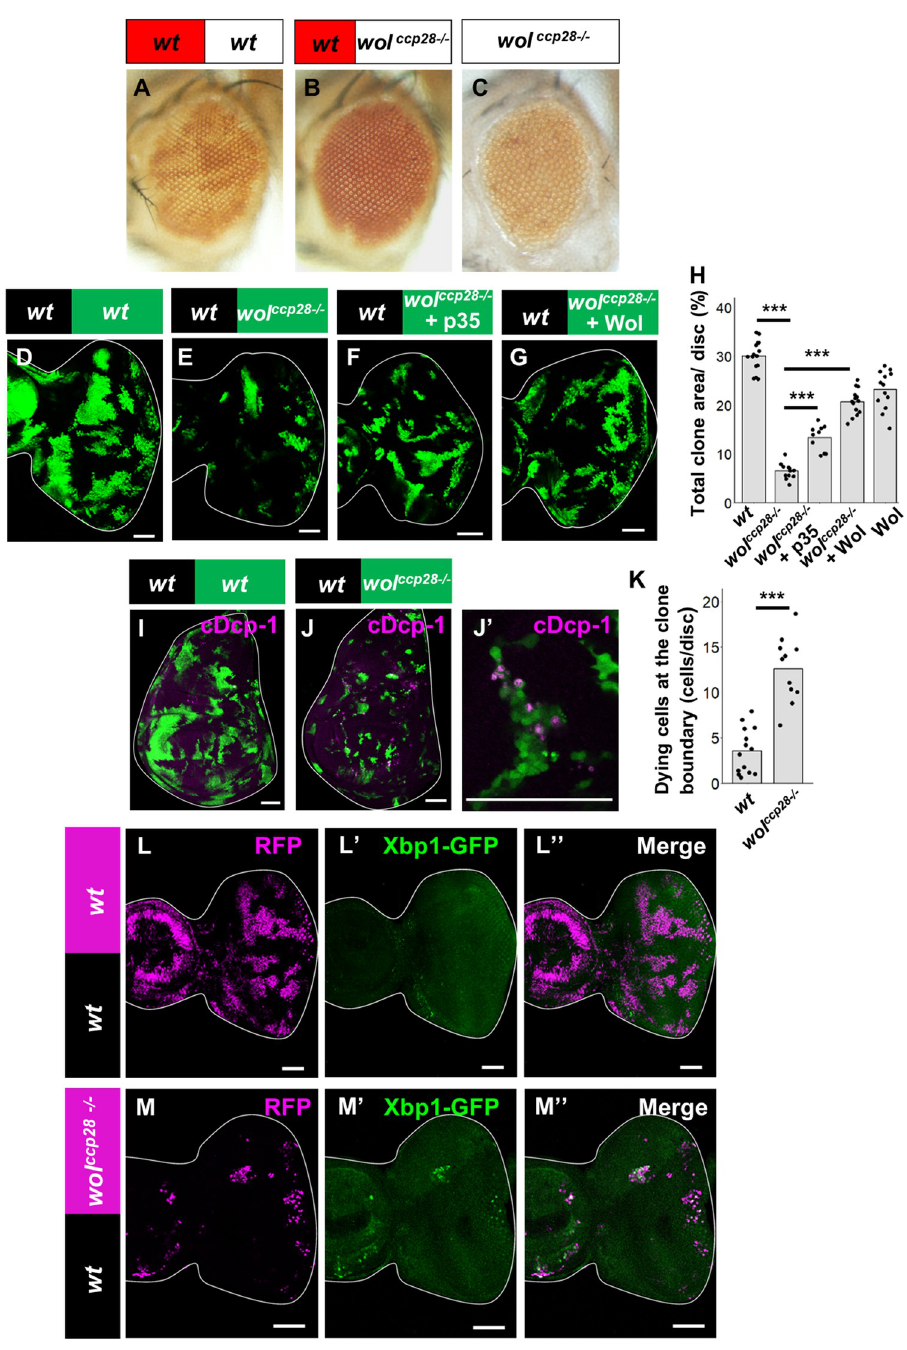
Fig 1. ER stress causes cell competition. (A and B) Adult eye bearing eyFLP-induced mosaics of wild-type (A) or wol ccp-28-/- (B) clones. (C) Adult eye bearing wol ccp-28-/- clones with surrounding wild-type tissue removed by GMR-hid and cell-lethal mutations. (D-G) Eye disc bearing eyFLP-induced MARCM clones of wild-type (D), wol ccp-28-/- (E), wol ccp-28-/- + UAS-p35 (F) cells or wol ccp-28-/- + UAS-wol (G) cells. (H) Quantification of the relative size of GFP-labeled clones shown in D-G. Error bars, SD; ��� p < 0.001by Steel-Dwass test. (I-J’) Wing disc bearing UbxFLP-induced MARCM clones of wild-type (I) or wol ccp-28-/- (J) stained with anti-cleaved Dcp-1. A magnified image of the inset in J is shown in J’. (K) Quantification of the numberof dying cells at the boundary between wild-type and wol ccp-28-/- clones in the wing discs. Error bars, SD; ��� p < 0.001 by Welch’s t-test. (L and M) Eye disc bearing eyFLP-induced MARCM clones of UAS-Xbp1-GFP (L) or wol ccp-28-/- + UAS-Xbp1-GFP (M) cells stained with anti-GFP. Scale bars, 50 μ m.See S1 Text for detailed